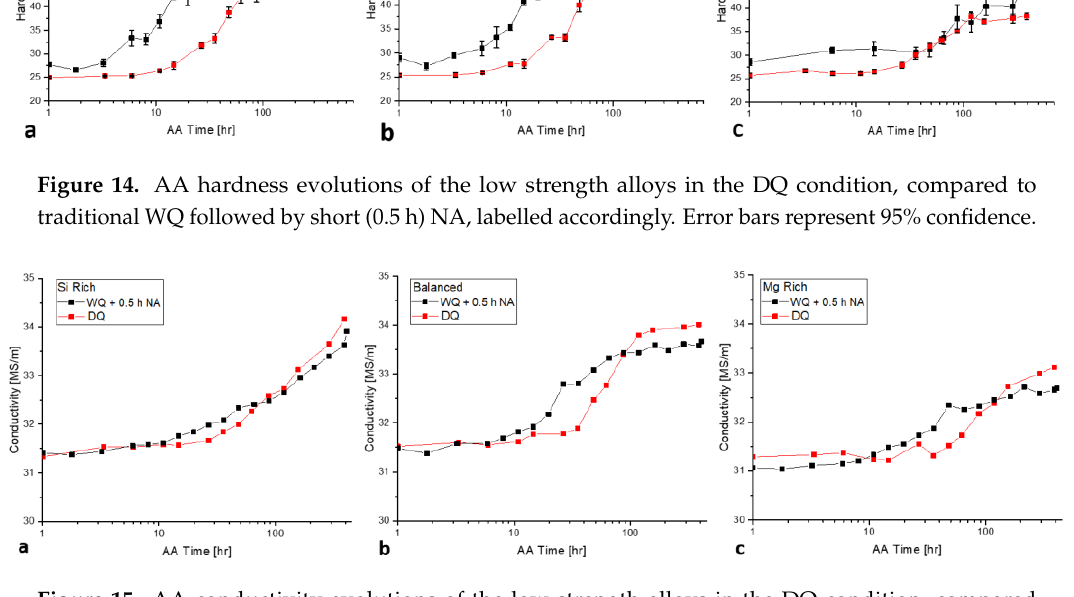
Figure 15. AA conductivity evolutions of the low strength alloys in the DQ condition, compared to traditional WQ followed by short (0.5 h) NA, labelled accordingly. Error bars are not visible at 95% confidence.